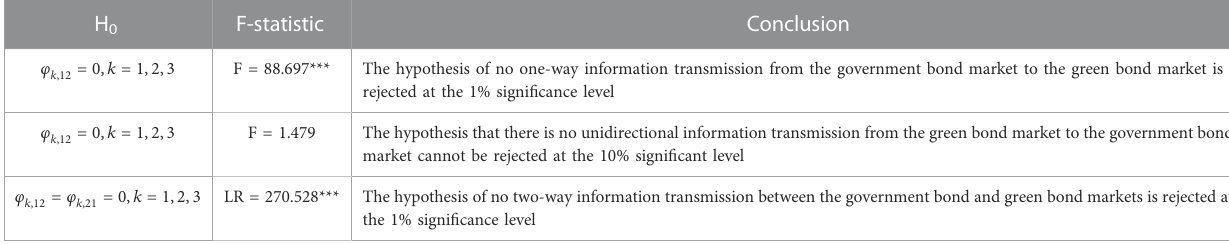
TABLE 7 Test of information transmission relationship between green bonds and the government bond market bene fi ts. H 0 F-statistic